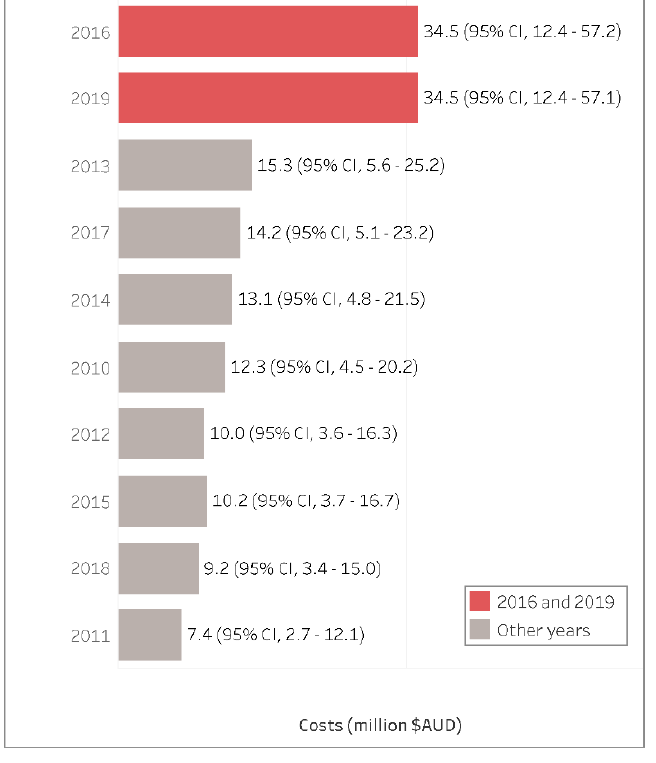
Figure 4. Total estimated LFS health costs per year in descending order (million AUD$ 2018).